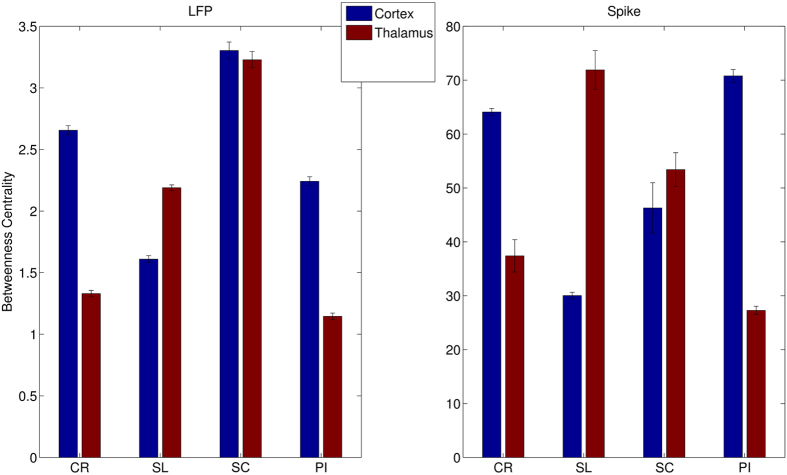
Analysis of betweenness centrality (BC). In the LFP (left), the BC is mainly distributed in S1 in normal animals while in SL the balancing is reversed, in SC appears equidistributed an in PI is barely maintained.A similar trend is shown also in the spiking activity (right). CR represents the control, PI the peripheral injury, the SC the sciatic constriction (Bennet-Xie model) and the SL (Seltzer model) animals.